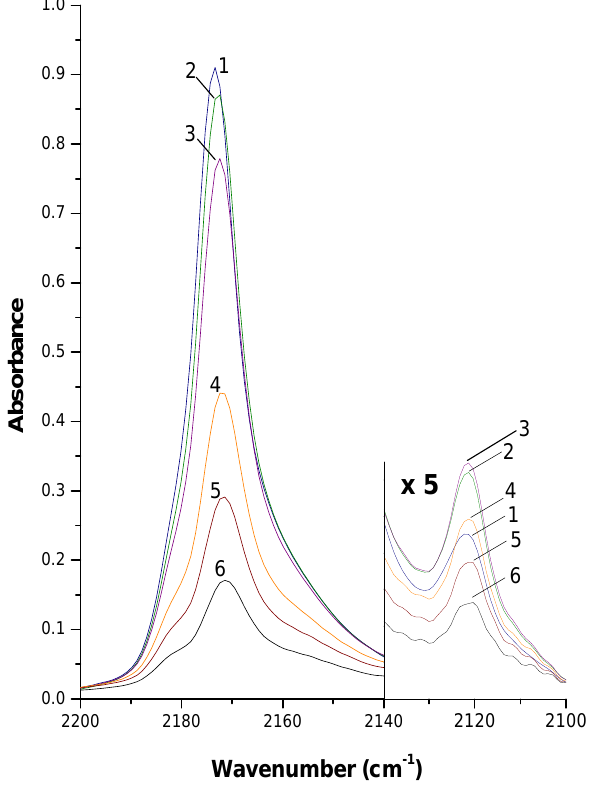
Figure 2. Selected spectra of CO ( ca . 1.5 Torr) adsorbed on Na-Y at variable temperature: ( 1 ) 167 K; ( 2 ) 187 K; ( 3 ) 197 K; ( 4 ) 215 K; ( 5 ) 225 K; ( 6 ) 233